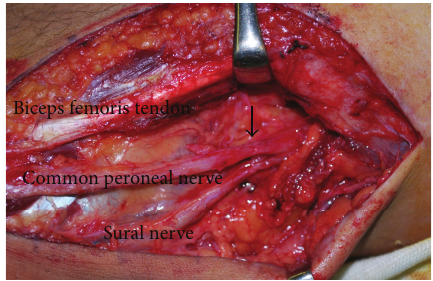
Figure 3: Photograph at reoperation. Hourglass-like constriction of common peroneal and sural nerve